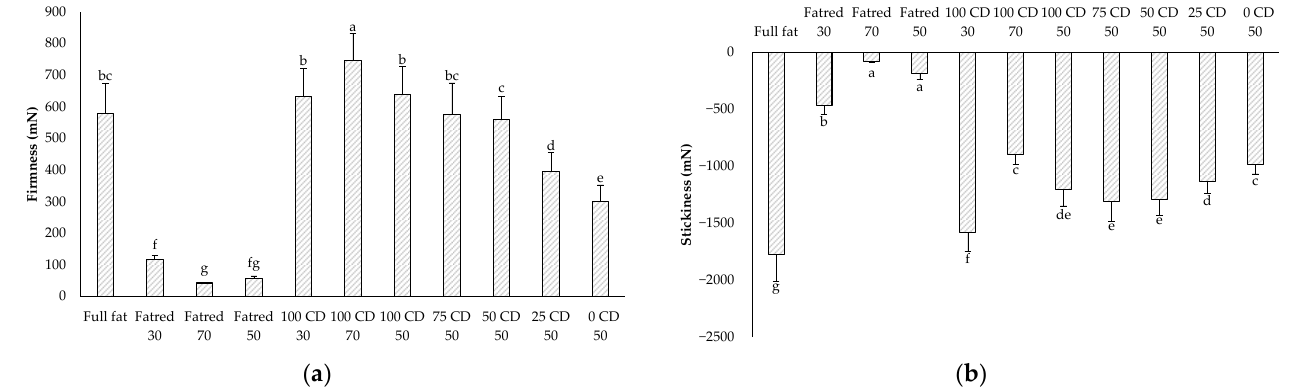
Figure 1. Firmness ( a ) and stickiness ( b ) of the PCS samples measured with the Texture Analyzer (CD = corn dextrin). The data are expressed as mean ± standard deviation ( n > 24). Bars with different letters indicate significant differences between samples ( p ≤ 0.05) following one-way ANOVA (Tukey).